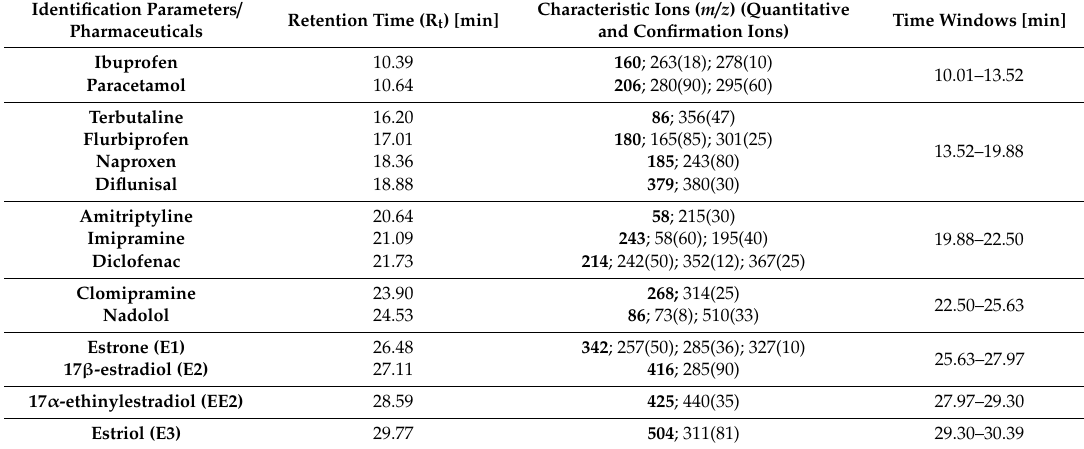
Table 7. Retention parameters (time allowed change ± 0.15 min), time windows, and SIM ions for trimethylsilyl (TMS)-derivatives of target compounds (quantitative ions are marked in bold; confirmation ions with intensity relative to quantitative ions